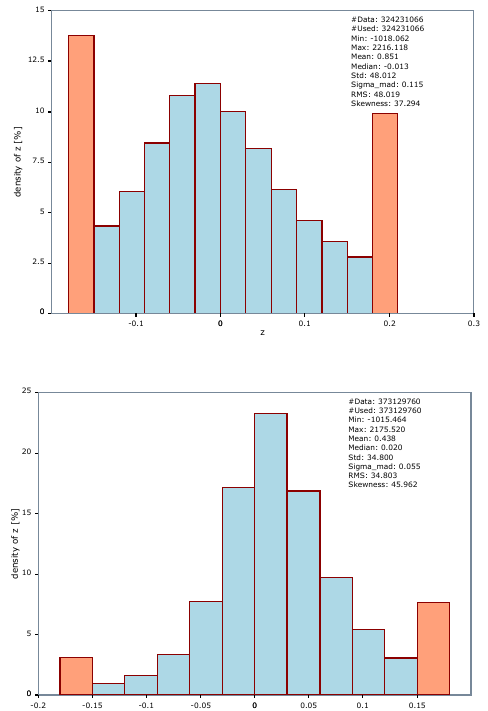
Figure 6: Digital surface model and shaded relief of the Ölgrube area (left) and diffuse Lambertian reflectance (right), derived by the results of FWF analysis. The toe of the rock glacier can be well distinguished from the surrounding area in the diffuse re- flectance model.